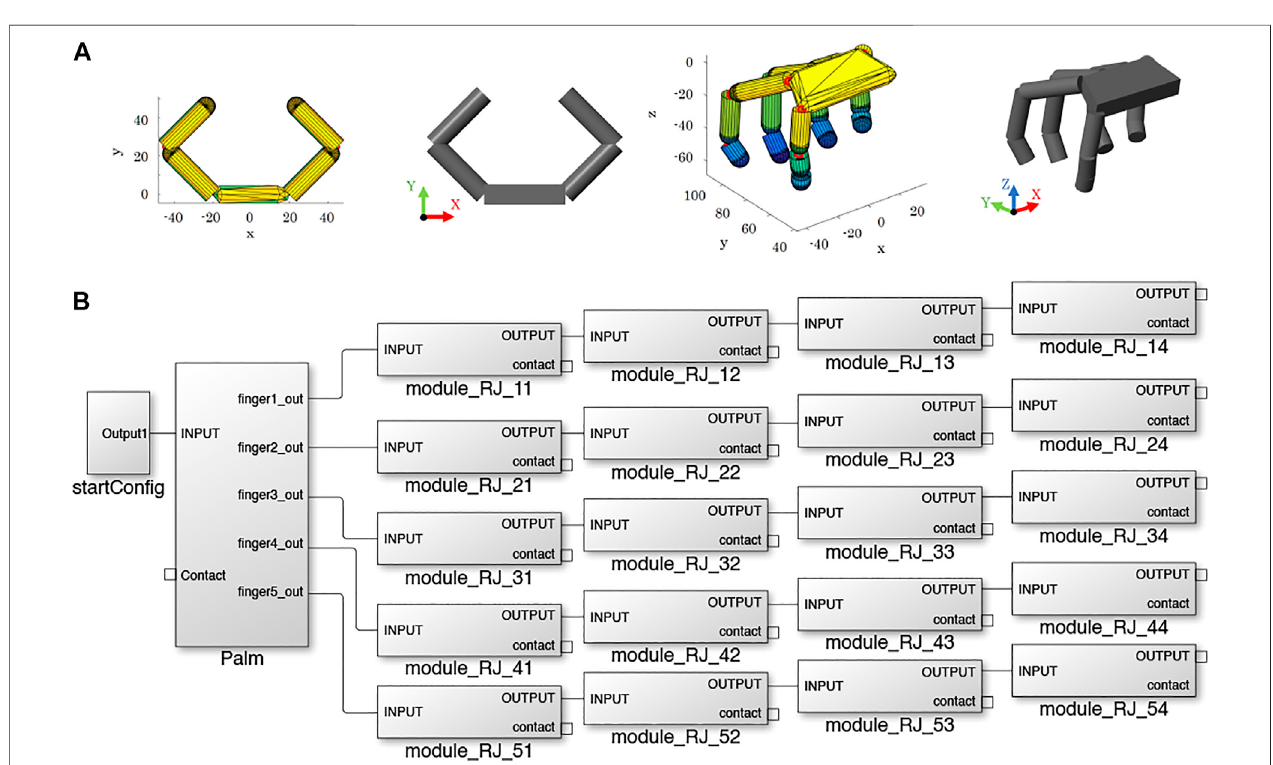
FIGURE 2 | Hand de fi nition. (A) Examples of hand models in SynGrasp (coloured) and in Simscape Multibody (grey): planar gripper with 2 fi ngers and anthropomorphic hand. (B) Simulink model of the anthropomorphic hand.